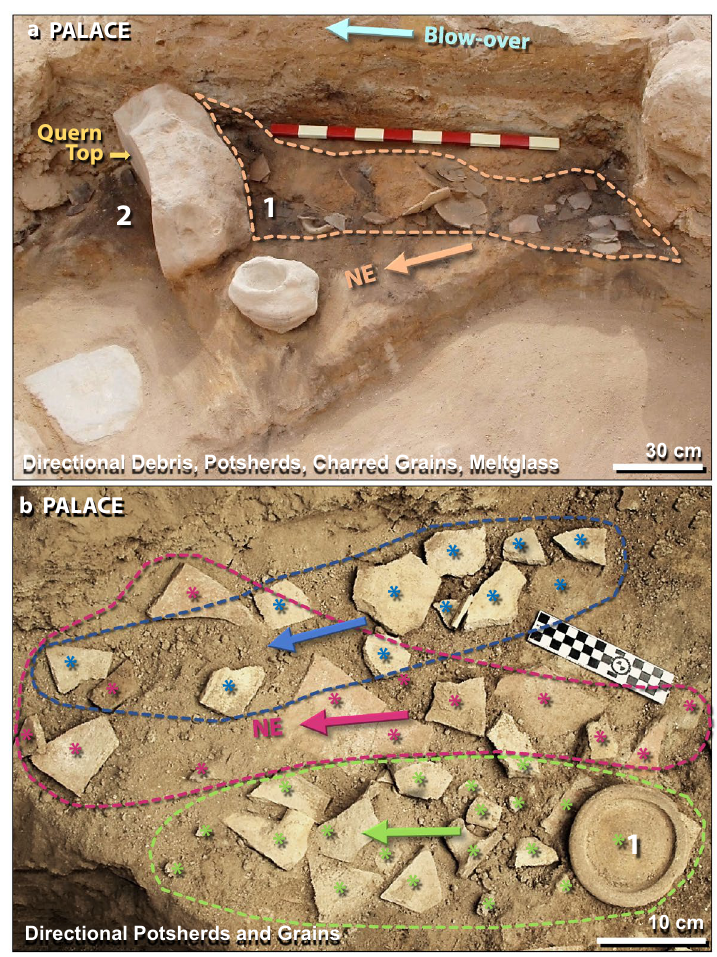
Figure 15. The directionality of mudbricks, potsherds, and grains. ( a ) 400-kg quern, at left, used for grinding grain, is tipped over with top towards NE. Image view spans ~ 2.5 m. Area #1 shows broken pottery and meltglass piled against quern from SW to NE (arrow). Area #2 contains charcoal, charred grains, ash, and mudbrick fragments, but no potsherds, suggesting that the quern shielded the floor to the NE. The area at the top labeled ‘blow-over’ is evidence that strong winds sealed the deposit with windblown laminated material that includes pulverized mudbrick, charcoal, ash, and fragments of white plaster. The draping of the blow- over indicates debris traveled from SW to NE. The scale stick is in 10-cm intervals. ( b ) Directional potsherds. Blue, red, and green asterisks (*) represent color-coded potsherds from three different pots. Arrows mark the motion of potsherds from SW to NE, spanning ~ 1 m. Area #1 represents the inverted bottom of the pot with its smaller fragments strewn to the left. Some pots contained charred grains also strewn in a SW-to-NE direction. Radiocarbon dates on charred grains confirm an age of ~ 1650 BCE (3600 cal